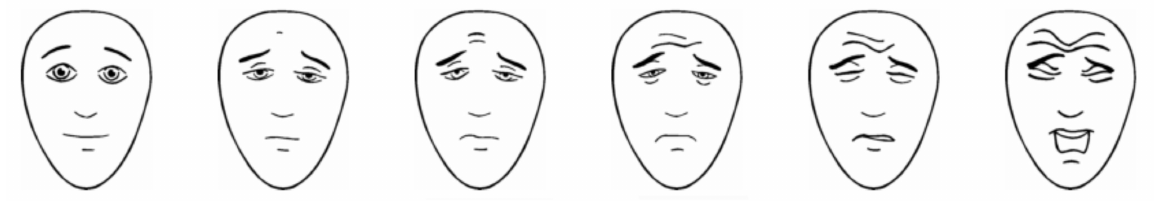
Figure 1. Facial hedonic scale (FHS) was used to evaluate the taste sensation of children between 6 to 10 years. The children reported the face that described their experience with the pODT best. The pointed-out face was then assigned a number by the staff ranging from 0 (“very good”) to 10 (“very